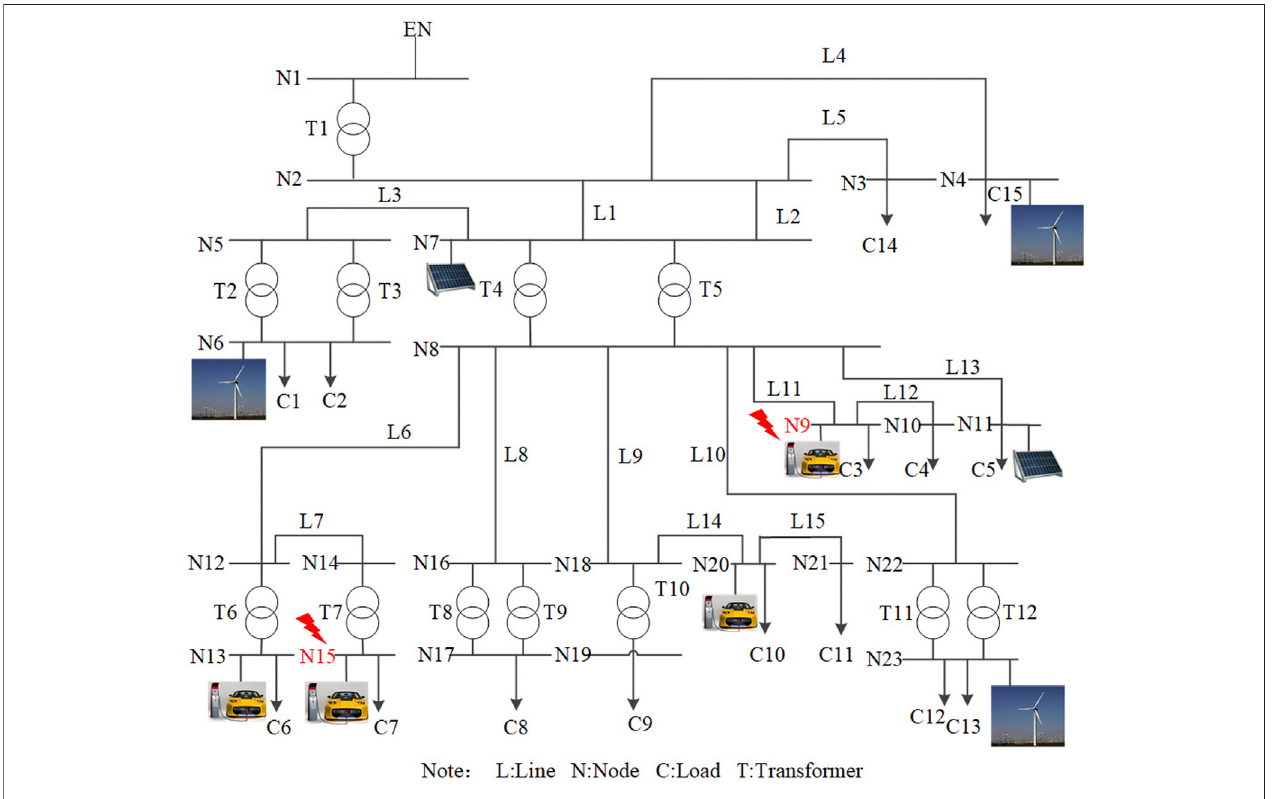
FIGURE 6 | Modi fi ed real coastal active distribution